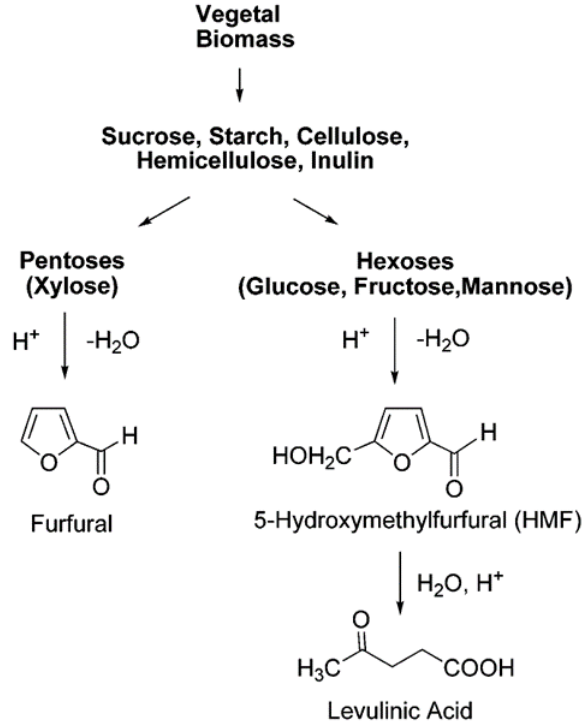
Figure 3. Products obtained from dehydration of monosaccharides.